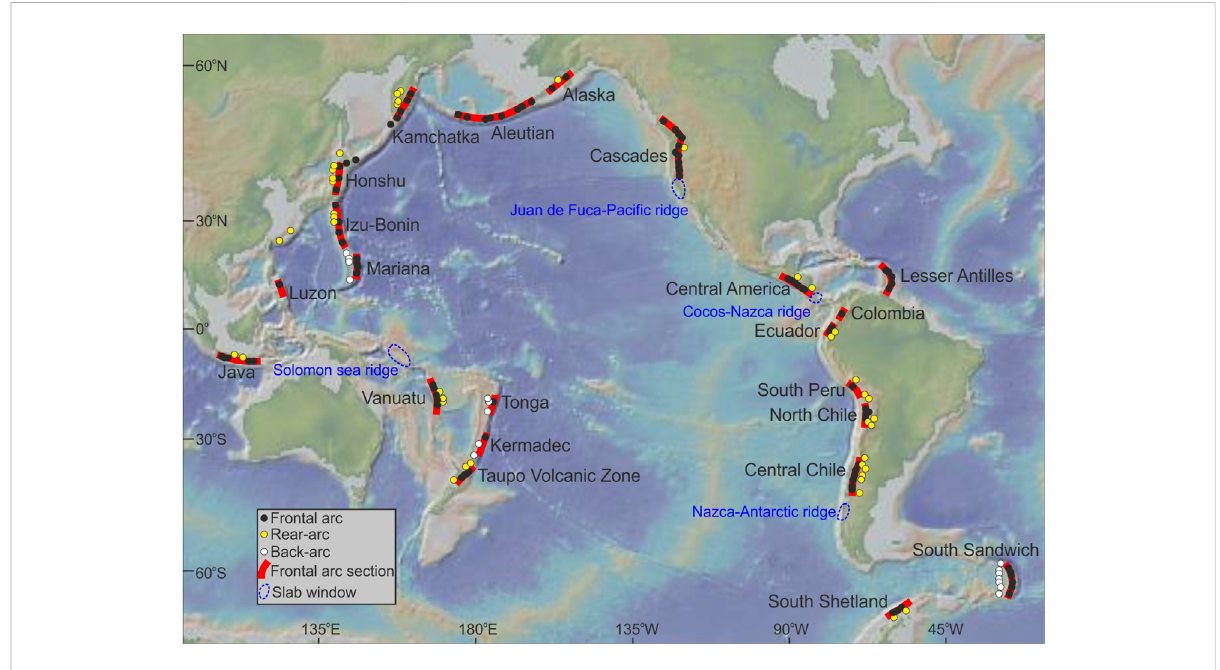
FIGURE 1 Quaternary arc volcanos compiled for this study. The background map was processed with GeoMapApp